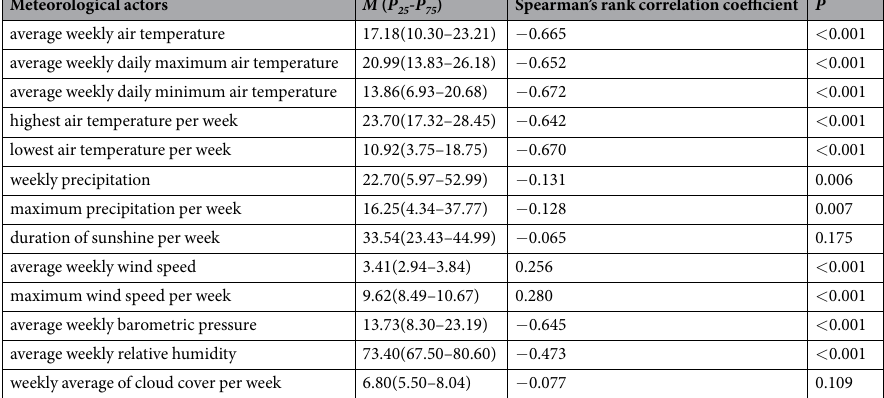
Table 1. The relationship between the log-incidence of influenza and the meteorological